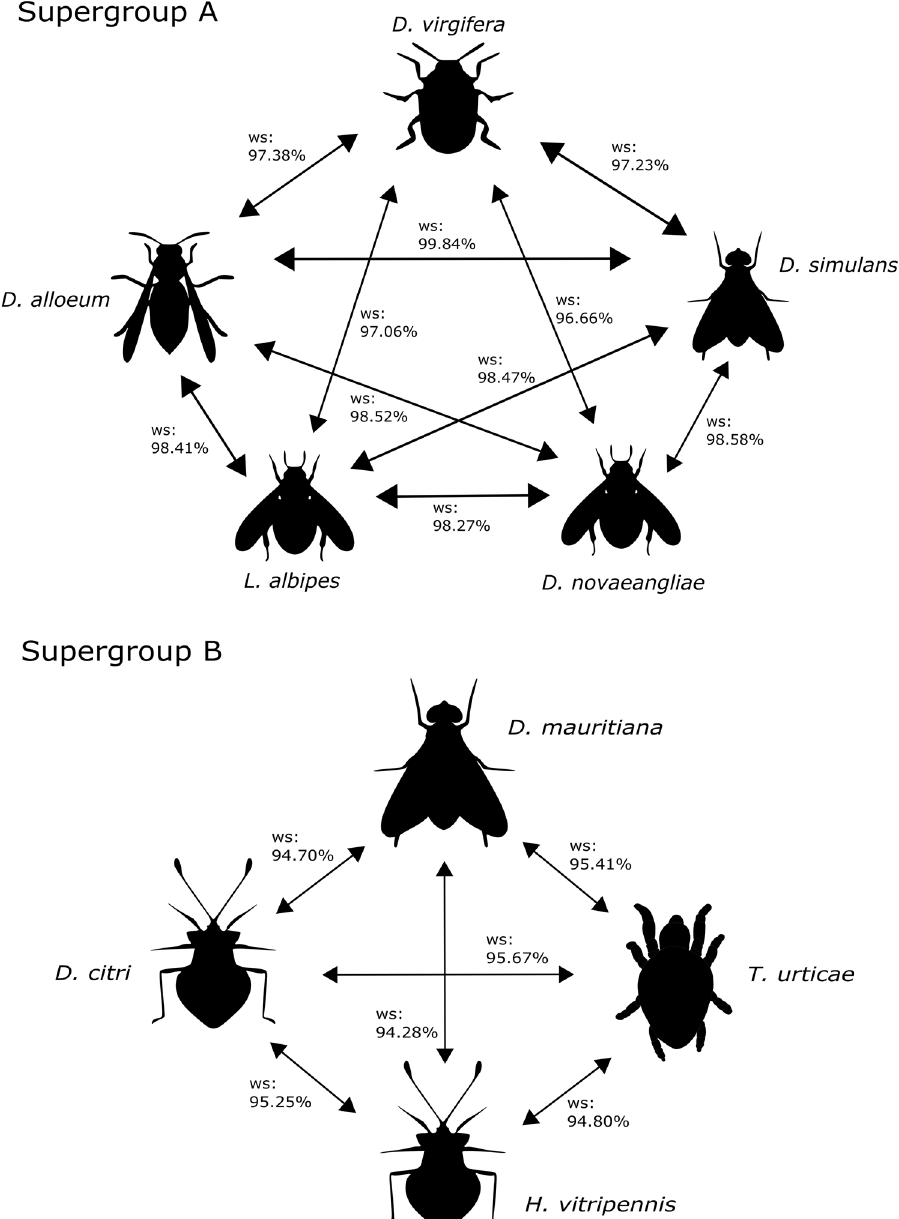
Figure 3. Wolbachia similarity between different hosts. The high Wolbachia similarity between distant related hosts is a strong evidence of HS since there is no feasible way of vertical transfer of Wolbachia between those hosts. ws, Wolbachia